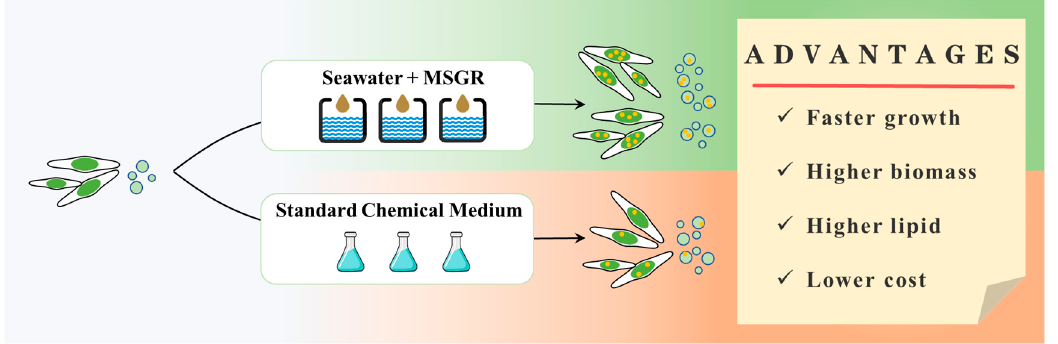
Figure 6. The benefits of using S-MSGR as a medium for biomass and biofuel production with P. tricornutum and N. oceanica .